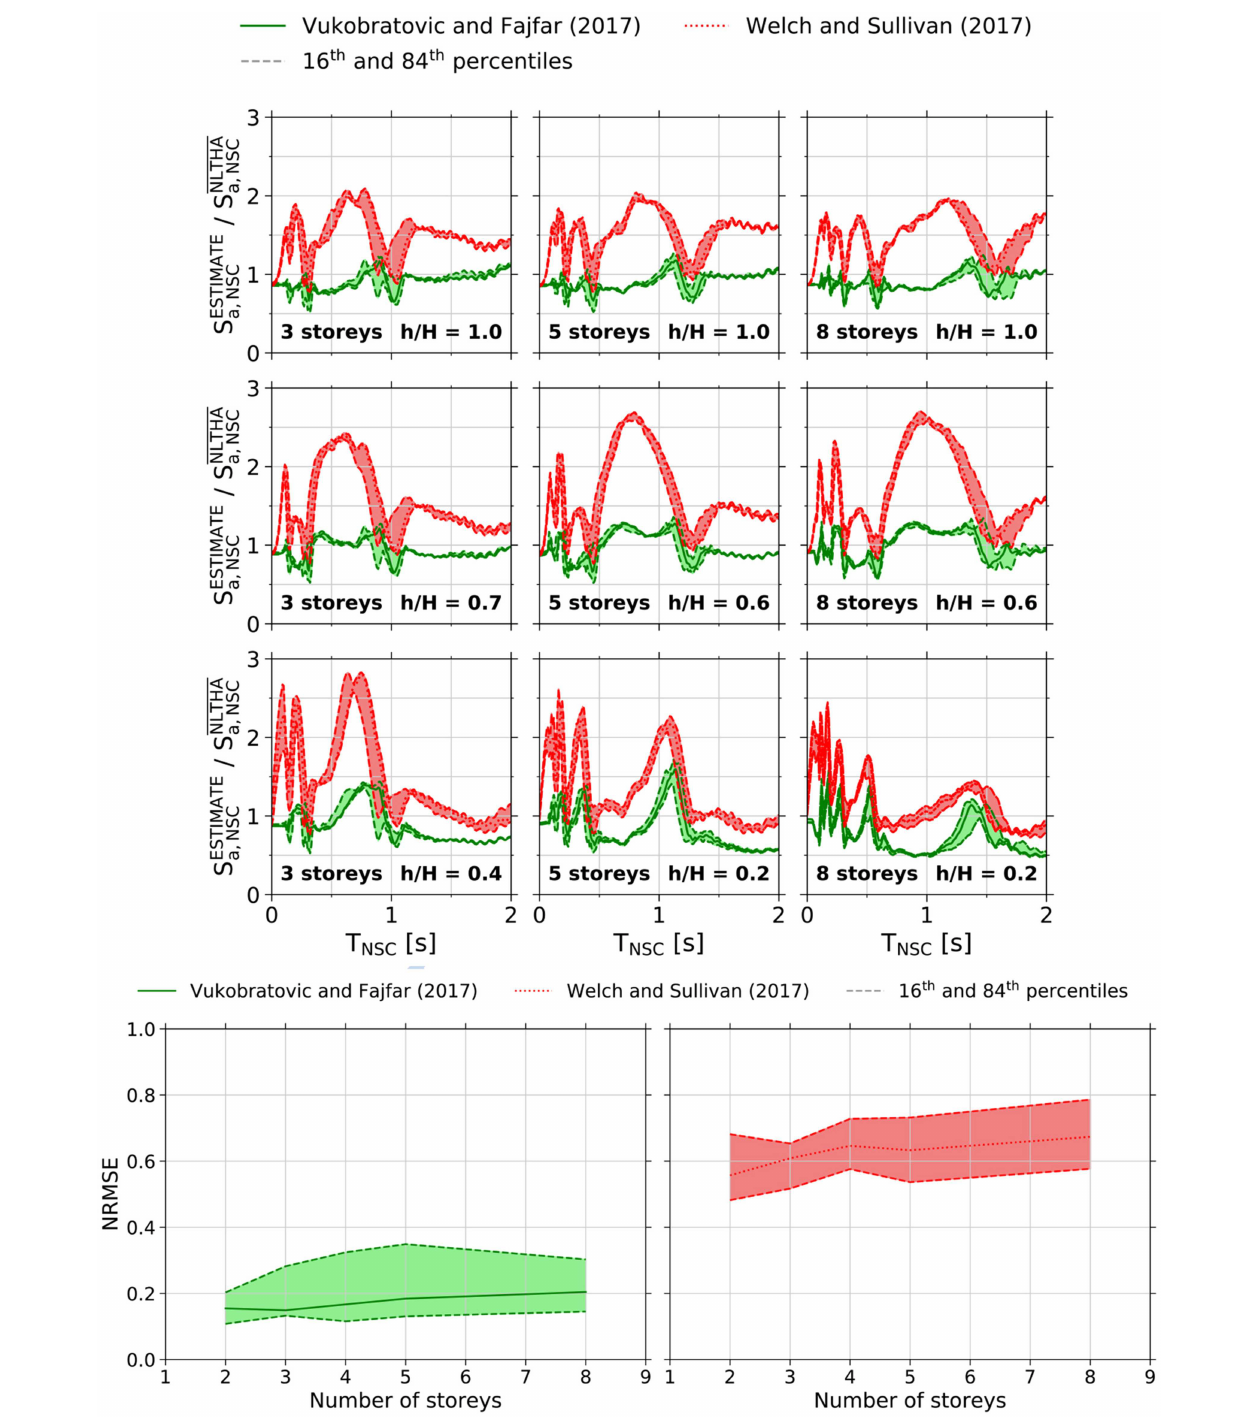
FIGURE 13 | Accuracy of FRS estimation procedures with targeted elastic ductility